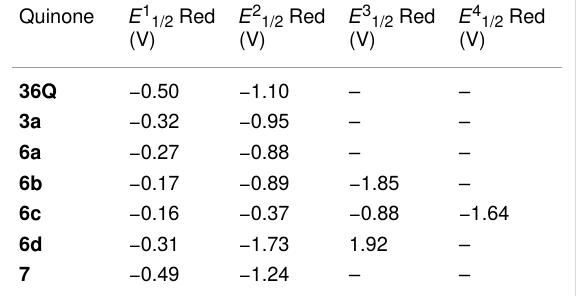
Table 1: Cyclovoltammetry data for o-quinones. Quinone